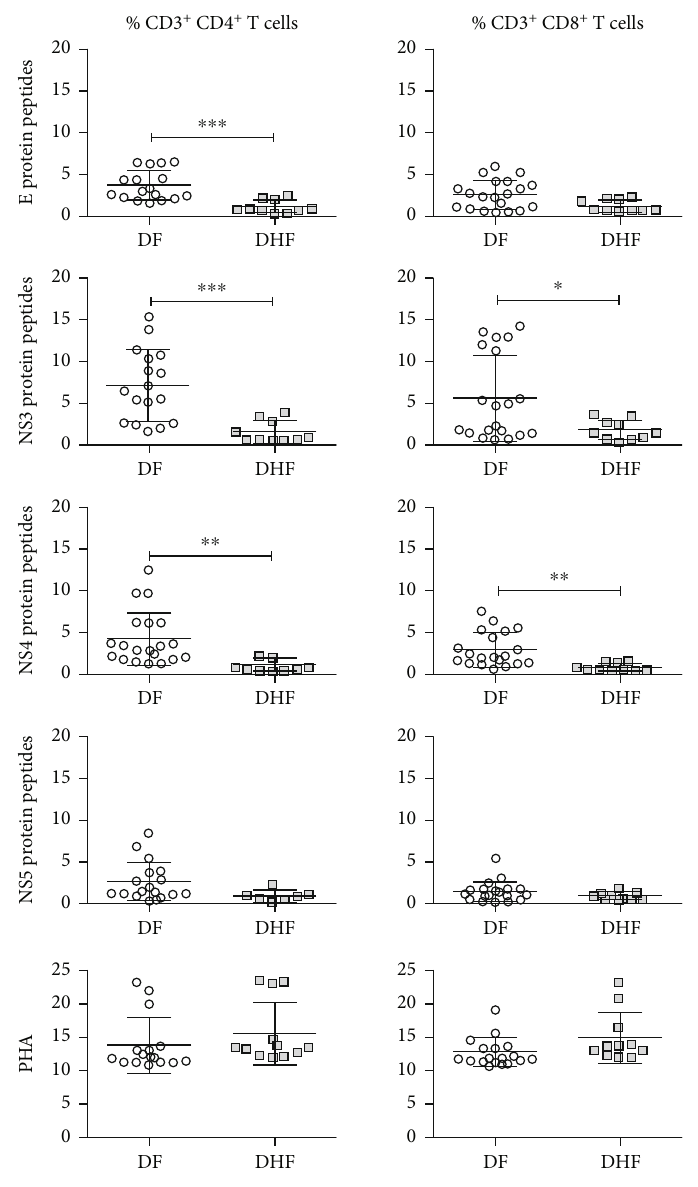
Figure 6: CD4 + and CD8 + proliferating cells stimulated with dengue virus peptides in dengue fever DF ( n = 23 ) or dengue hemorrhagic fever DHF ( n = 20 ) patients. Plots show the proportion of CD4 + and CD8 + cells induced by peptides of E, NS3, NS4, and NS5 viral proteins and the positive control stimulated with PHA. Error bars represent the mean ± SD . Signi fi cant di ff erences ∗ p < 0 : 05 , ∗∗ p < 0 : 01 , and ∗∗∗ p < 0 : 001 by the Mann – Whitney U